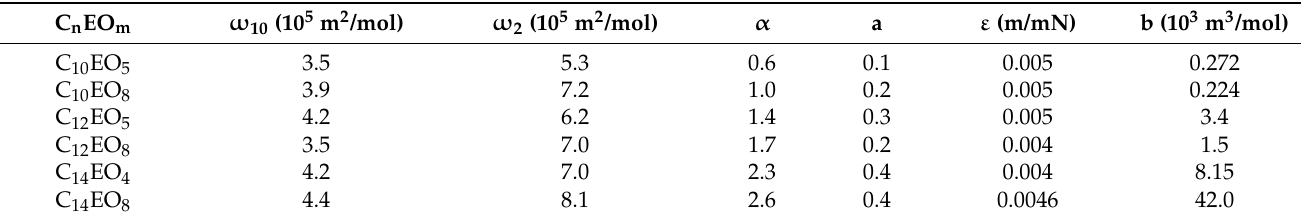
Table 1. Parameters of the isotherms of C n EO m solutions for the reorientation model. C n EO m